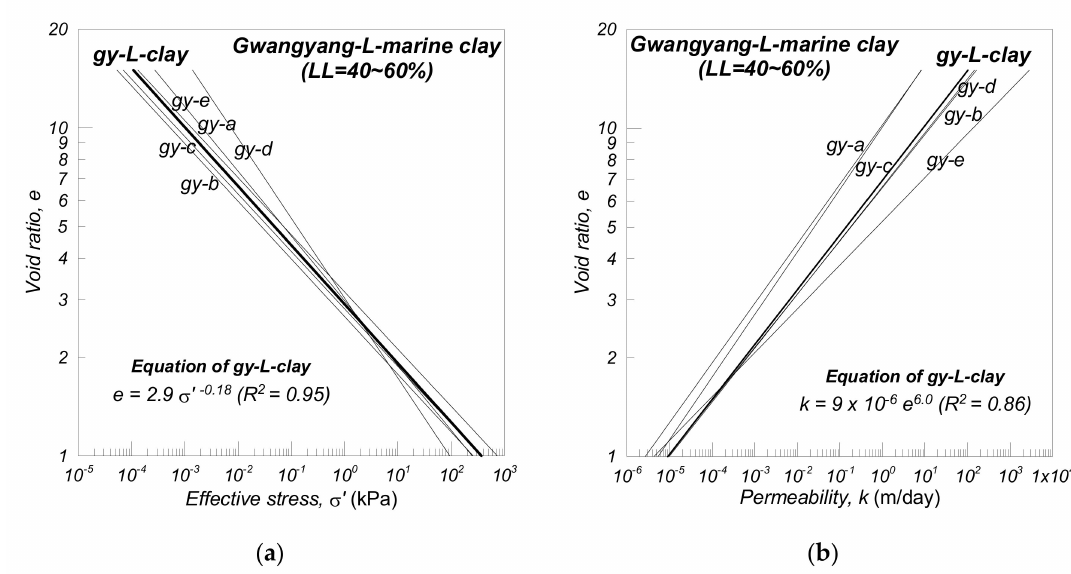
Figure 12. Constitutive relationship of Gwangyang L marine clay (gy-L-clay): ( a ) void ratio vs. e ff ective stress; ( b ) void ratio vs. permeability.